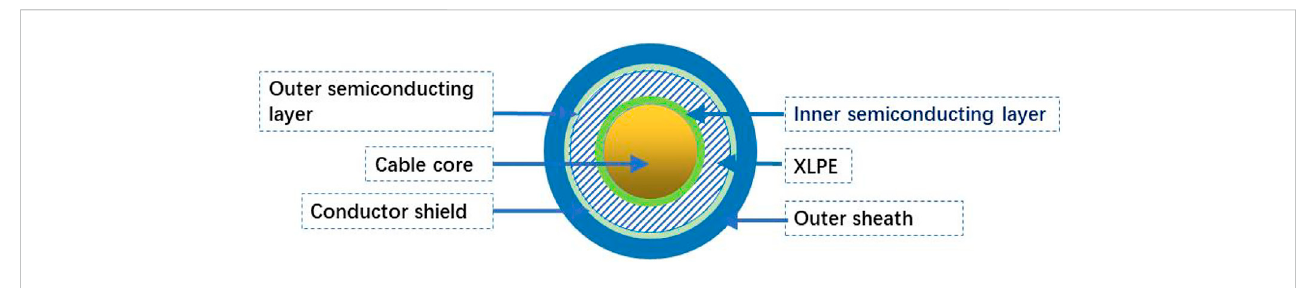
FIGURE 7 Simpli fi ed structure diagram of single-core